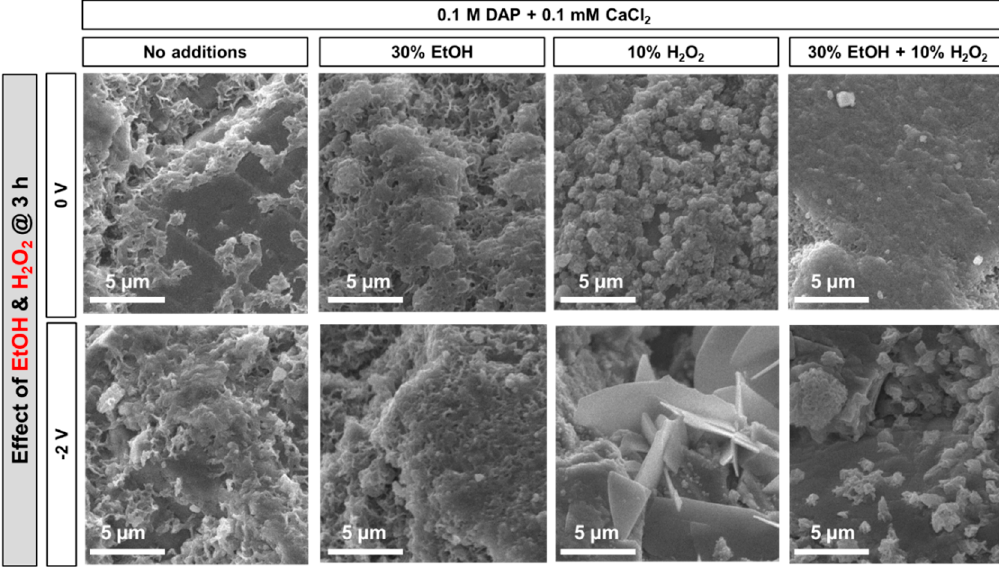
Figure 6. Effect of EtOH and H 2 O 2 addition on the morphology of the new CaP phases formed with and without electrodeposition.